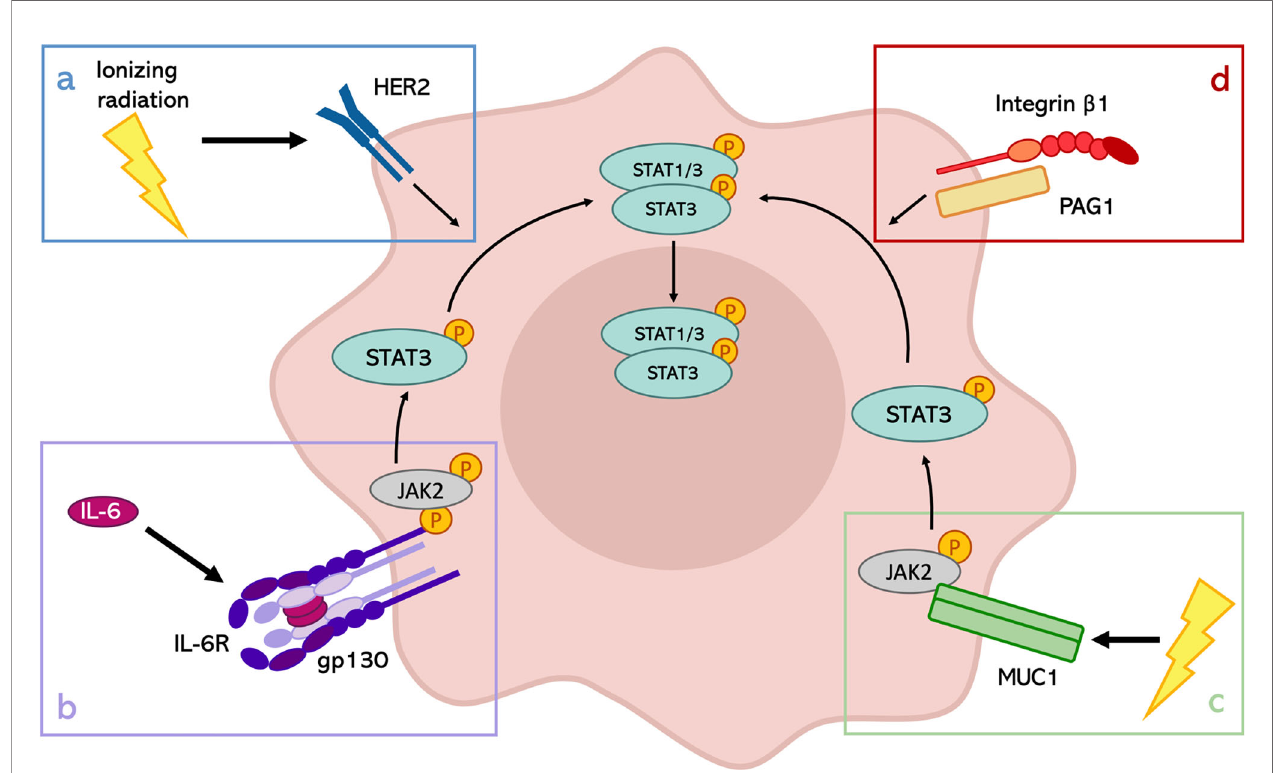
FIGURE 1 | Mechanisms of STAT3 activation in response to IR. Depending on the tumor type, STAT3 can be activated in different ways after IR exposure. (A) STAT3 phosphorylation through the activation of HER2 receptor in HER2-positive breast cancer; (B) role of IL-6 signaling in the activation of the JAK2/STAT3 pathway in pharyngeal cancer, HCC and prostate cancer; (C) involvement of MUC1 in HCC radioresistance; (D) formation of PAG1-Integrin b 1 complexes to induce the activation of STAT3 in laryngeal